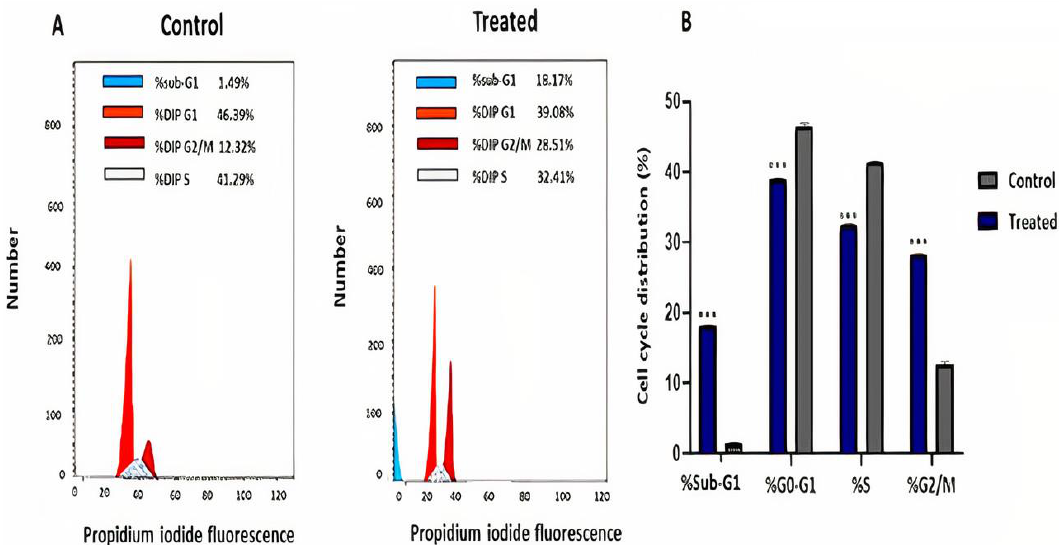
Figure 3. Cell cycle analysis of HepG2 cells treated with IC 50 value of R. nomadica venom for 48 h by flow cytometry. ( A ) Representative profiles of cell cycle distribution in HepG2 cells after treatments. ( B ) The percentages of cell populations in sub-G1, G0–G1, S and G2/M phases. Data are analyzed with paired Student’s t-test. Values are represented as mean ± SEM. *** denotes significance difference ( p < 0.001) vs. control.